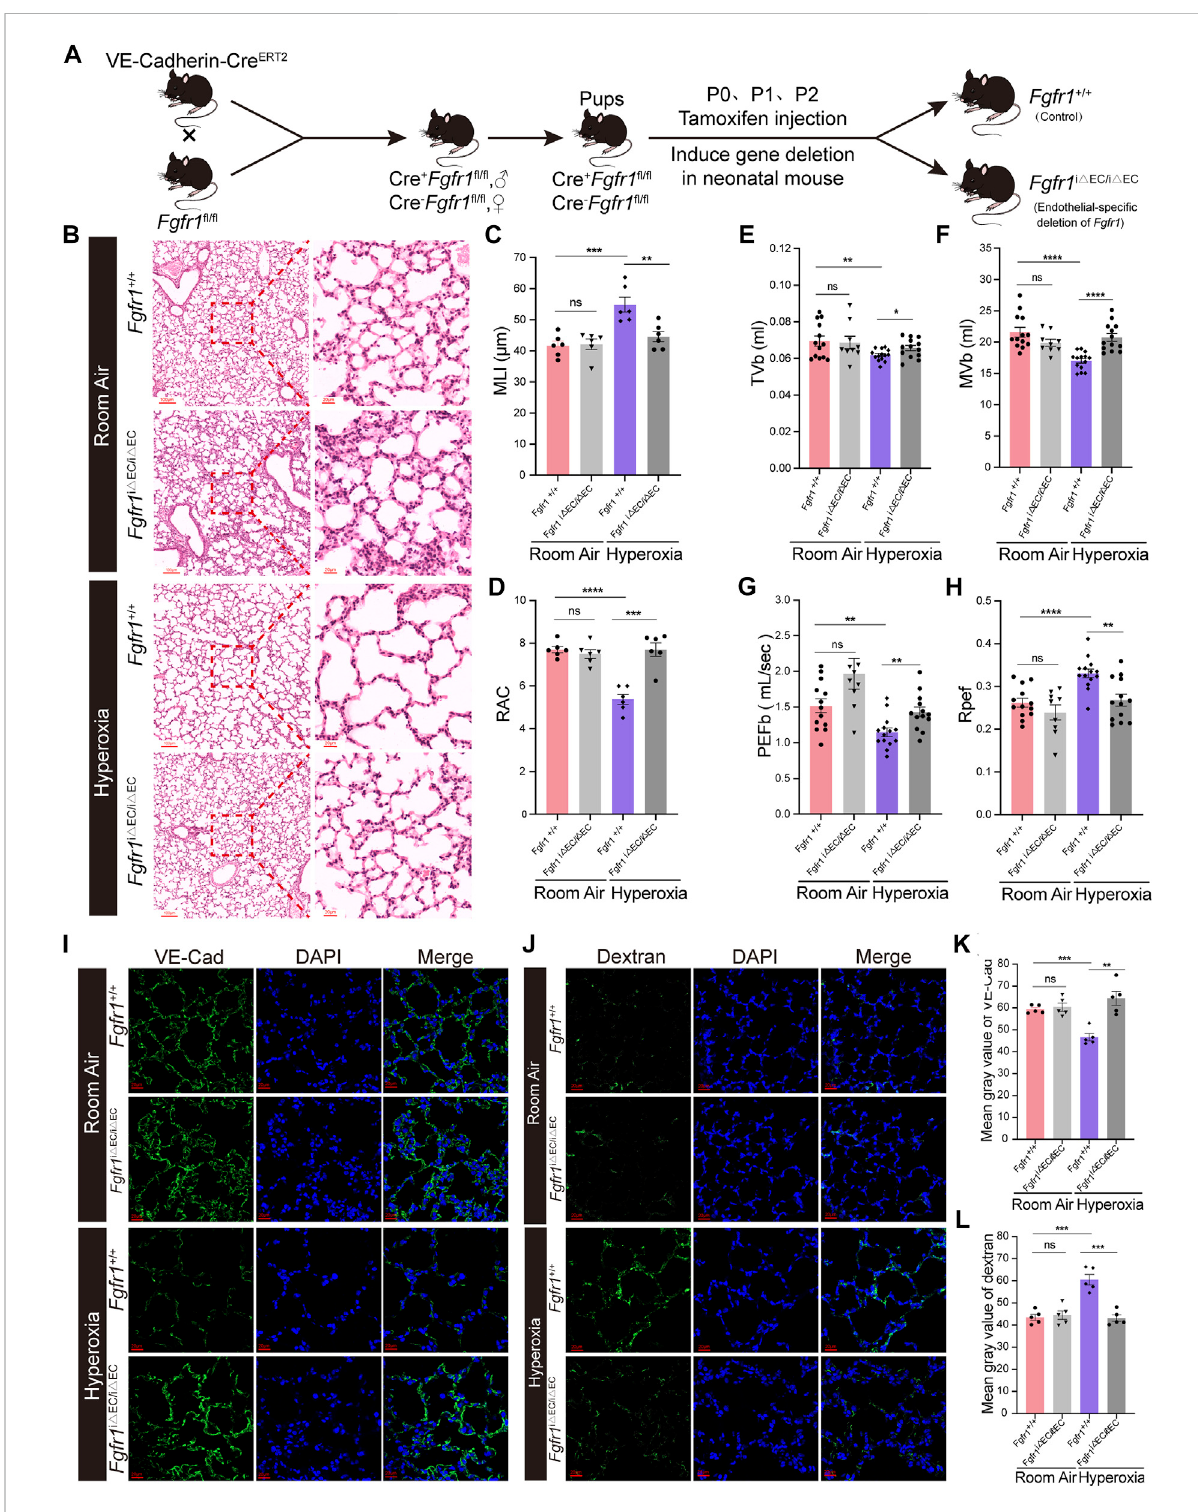
Deletion of endothelial Fgfr1 improved alveolar development and respiratory metrics and angiogenesis in mice upon hyperoxia. (A) Schematic representation of EC-speci fi c inducible deletion of Fgfr1 in neonatal mice. (B) Representative images of H&E-stained lungs from Fgfr1 +/+ and Fgfr1 i Δ EC/i Δ EC micerearedinroomairorhyperoxia.Thetoppanelshowslow-magni fi cation(scalebar=100 μ